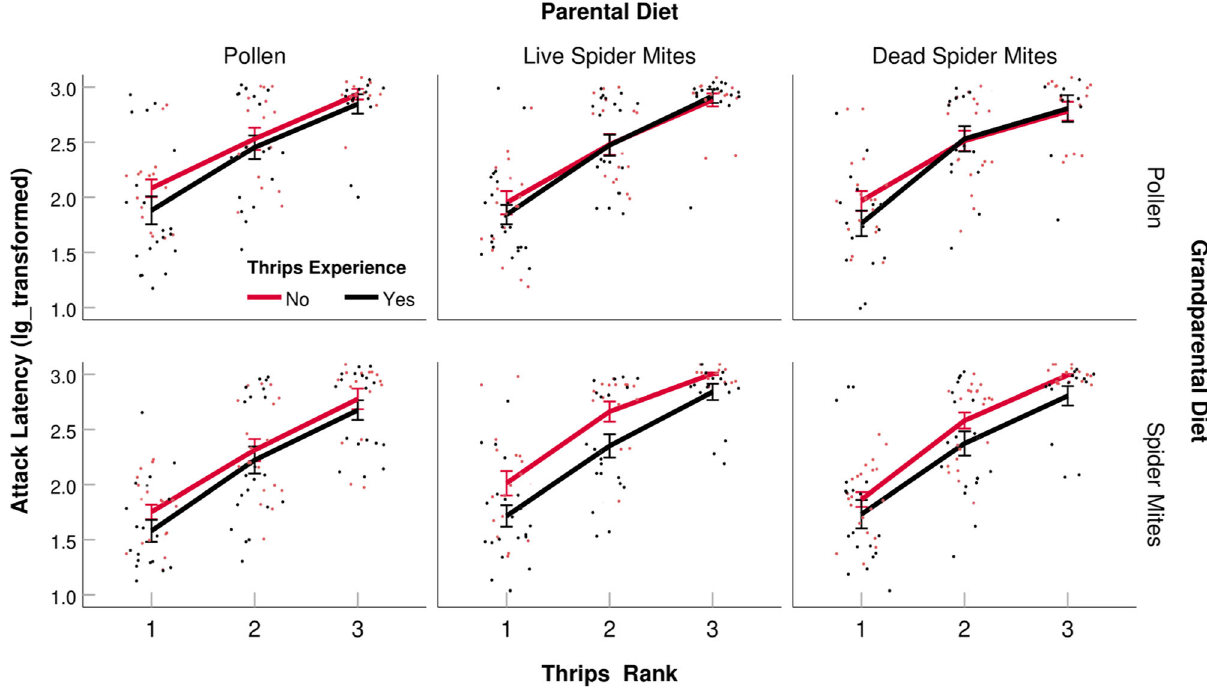
Fig. 3 Latency to attack all three prey individuals. Attack latency (min, lg_transformed; mean ± SE and individual data points) on the 1st, 2nd and 3rd out of three 1st instar thrips, F. occidentalis , presented to single mated A. swirskii females inside acrylic cages within 24 h. Predatory mite females had experienced thrips early in life or not ( + or − ) and were the progeny of parents fed Typha pollen (P), life spider mites (L), or dead spider mites (D), and grandparents fed Typha pollen (P) or live spider mites (L). The numbers of replicates ( n ; independent experimental animals) within treatments (sequence in treatment acronyms is grandparental diet, parental diet, early life experience by progeny) are 21 (LP + ), 21 (LP − ), 21 (LL + ), 18 (LL − ), 20 (LD + ), 22 (LD − ), 20 (PP + ), 20 (PP − ), 23 (PL + ), 20 (PL − ), 16 (PD + ), 19 (PD − ). Grandparental diet, thrips experience, and their interaction had signi fi cant effects (GEE, P < 0.01; see Table 2 for complete statistical results).